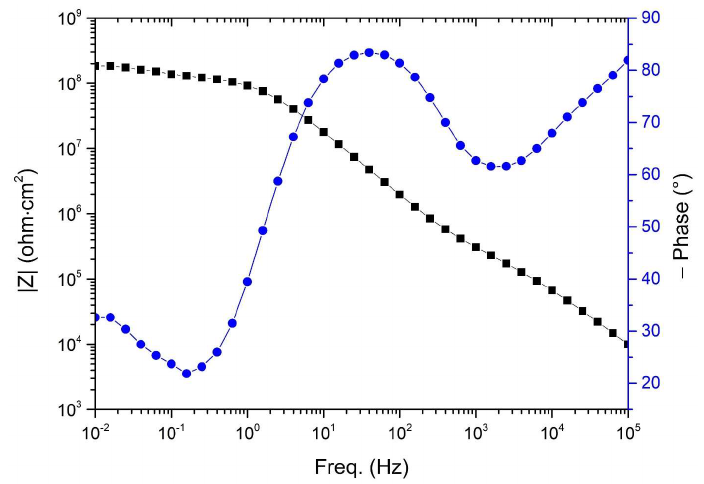
Figure 11. Example of the impedance modulus plot for a painted steel sample characterized by a minimum at high frequencies.